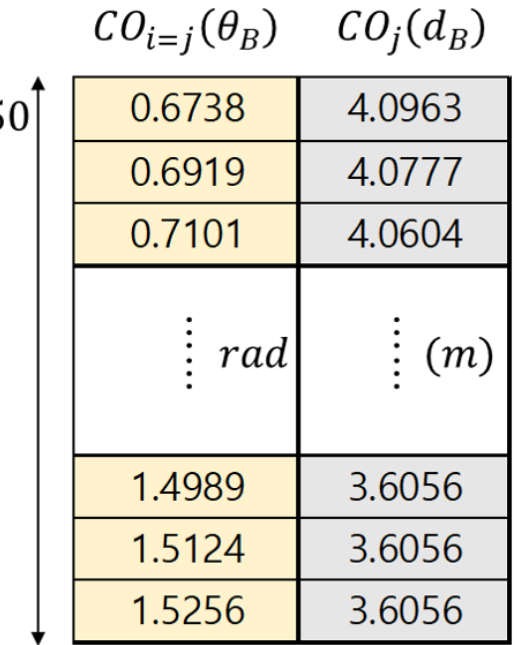
Figure 22. The two 50 by 1 matrices about CO i = j ( θ B ) and CO j ( d B )